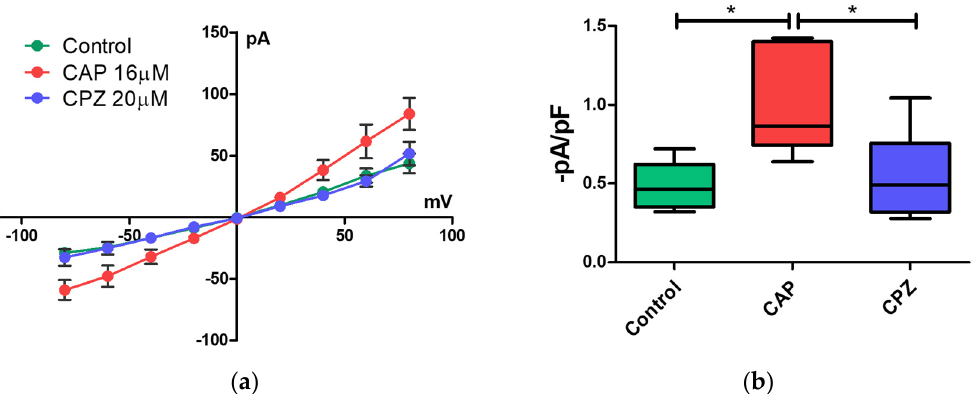
Figure 4. Whole-cell patch-clamp recordings. ( a ) Voltage-current plots before (control—green dots) and after application of 16 µM capsaicin (CAP—red dots) and 20 µM of capsazepine (CPZ—blue dots). Presence of CAP increased the ion currents. Subsequent perfusion with CPZ lower CAP-induced ion currents to a level similar to the control. ( b ) Current density of control, CAP-, and CPZ-perfused cells at − 80mV. A significant increase in current density was observed in the CAP-treated cells in comparison to control and CPZ. Significance was denoted with an asterisk (*). Values expressed as mean ± s.e.m., n = 6, one-way ANOVA, with Tukey’s post hoc test ( p < 0.05).